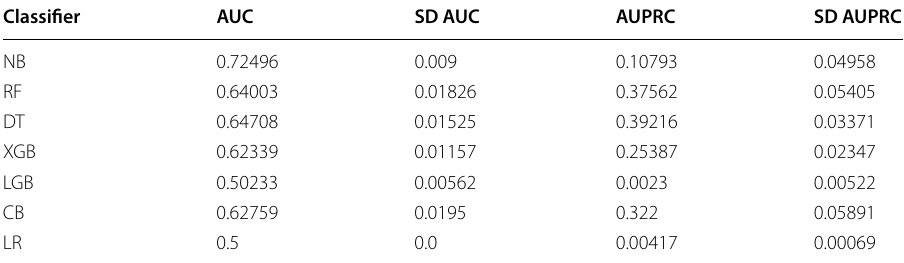
Table 7 Results for classification with no sampling; classifiers: NB is Naive Bayes, RF is Random Forest, DT is Decision Tree, XGB is XGBoost, LGB is LightGBM, CB is CatBoost, LR is Logistic Regression; AUC stands for Area Under the Receiver Operating Characteristic Curve; SD stands for standard deviation reported for every metric; AUPRC stands for Area under the Precision-Recall Curve Classifier AUC SD